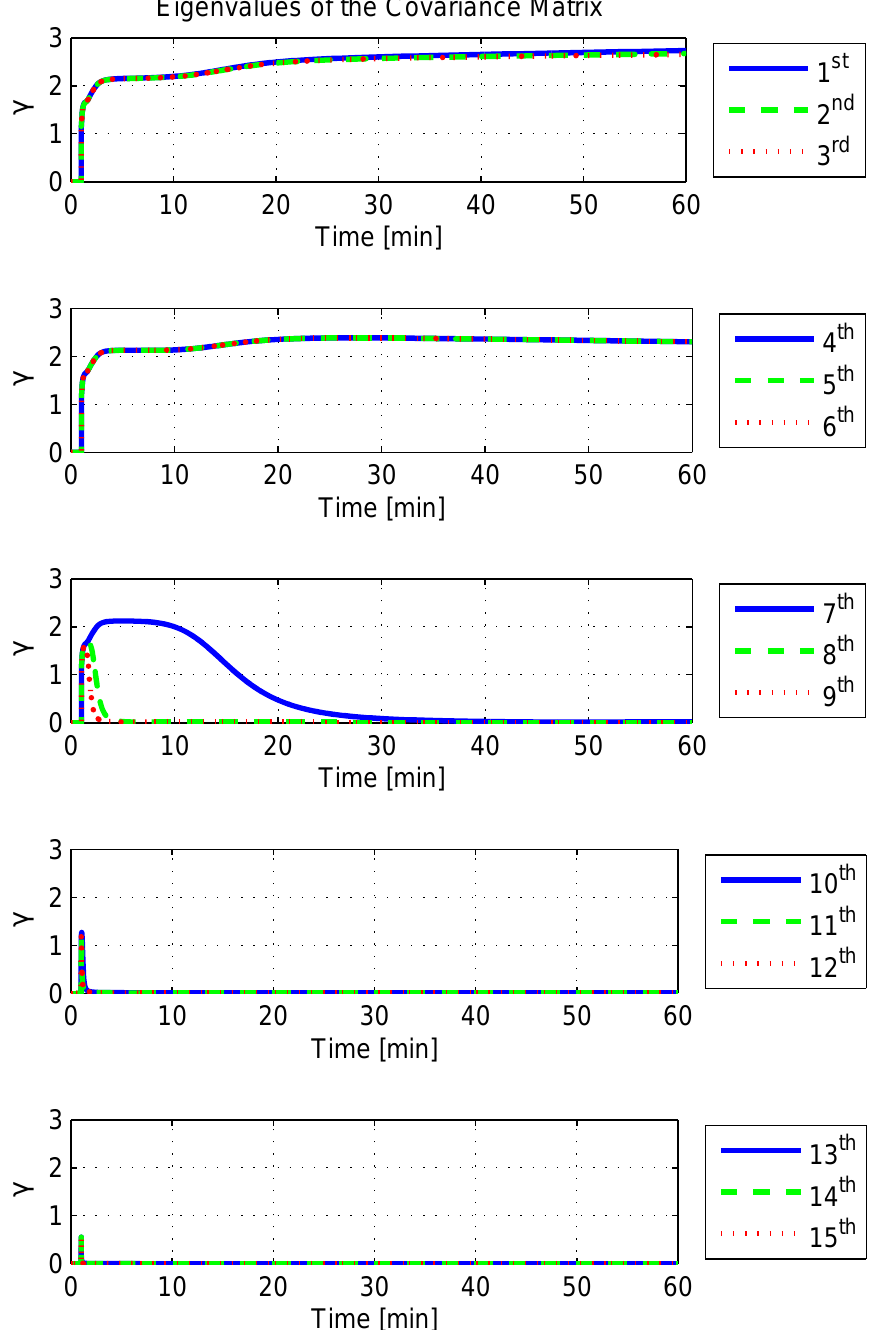
Figure 22. Eigenvalues of the covariance matrix in repeated experimental